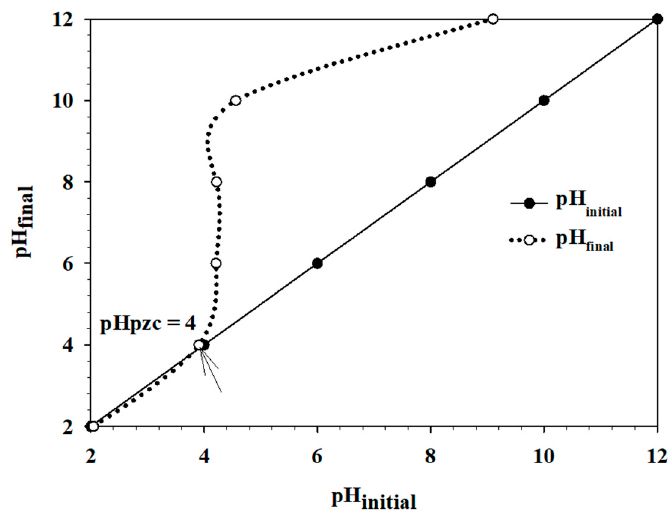
Figure 11. The pH point of zero charge (pHpzc) plot of Mo/HRTiO 2